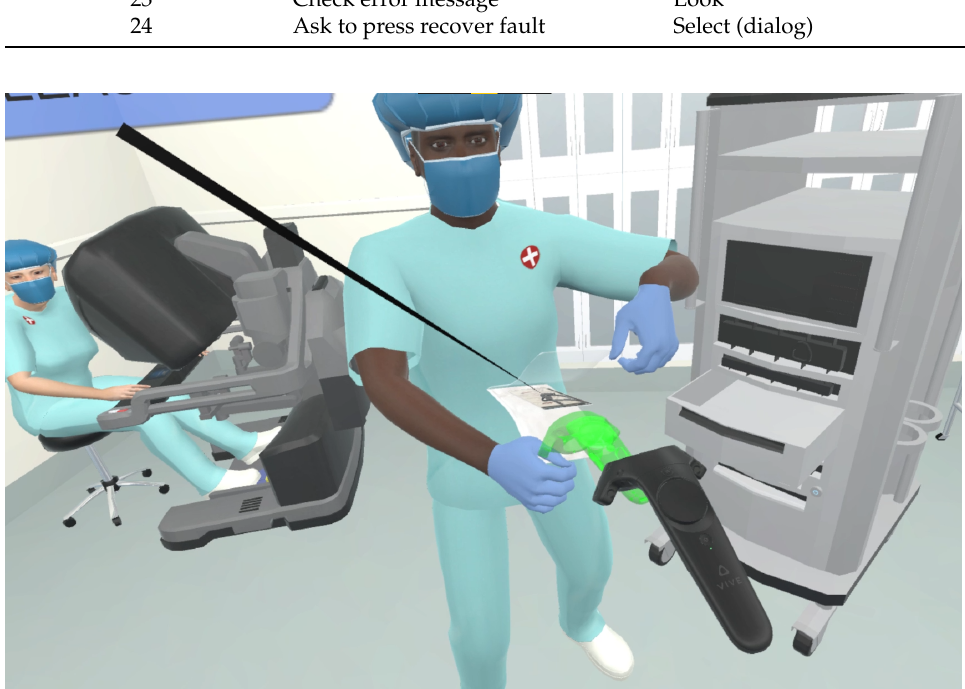
Figure 1. A first-person perspective of the VR training application used for our